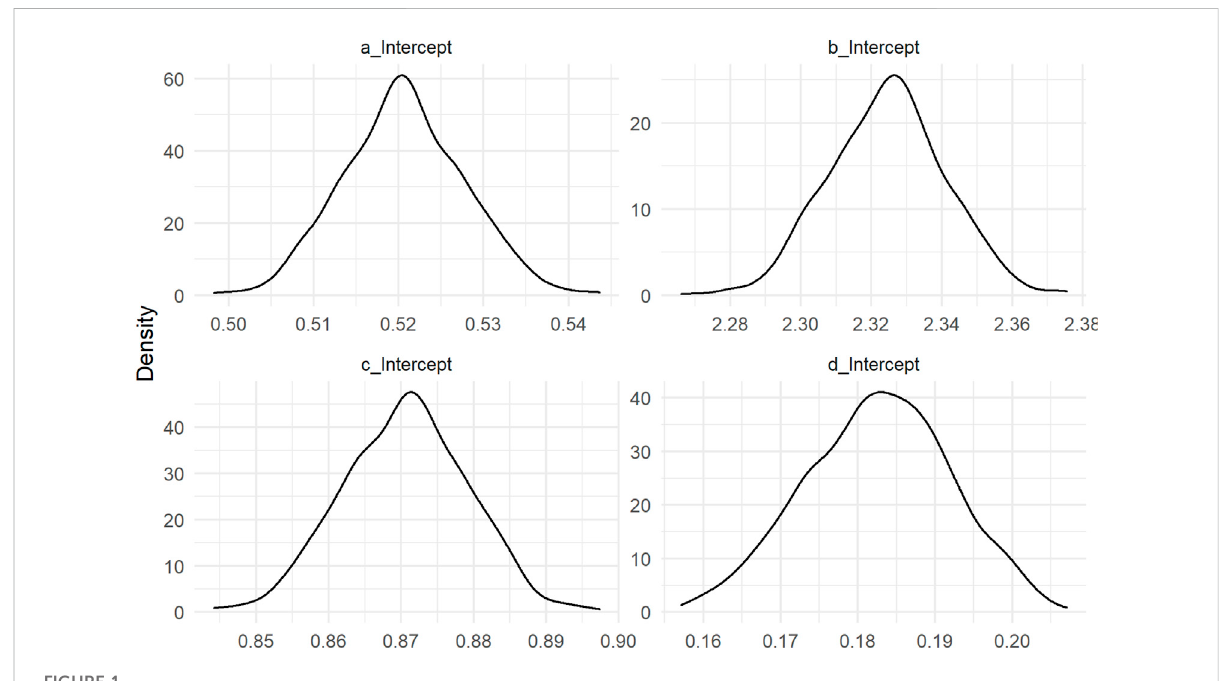
FIGURE 1 Density of the estimated fi xed parameters of the model.